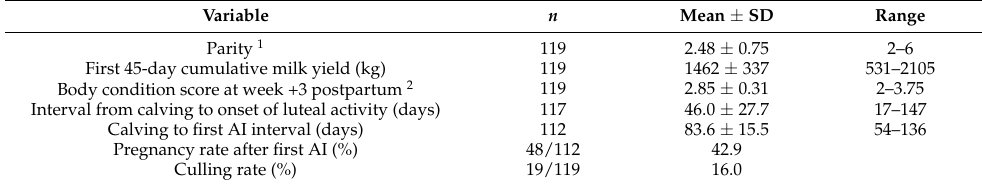
Table 1. Descriptive statistics for the 119 studied Holstein